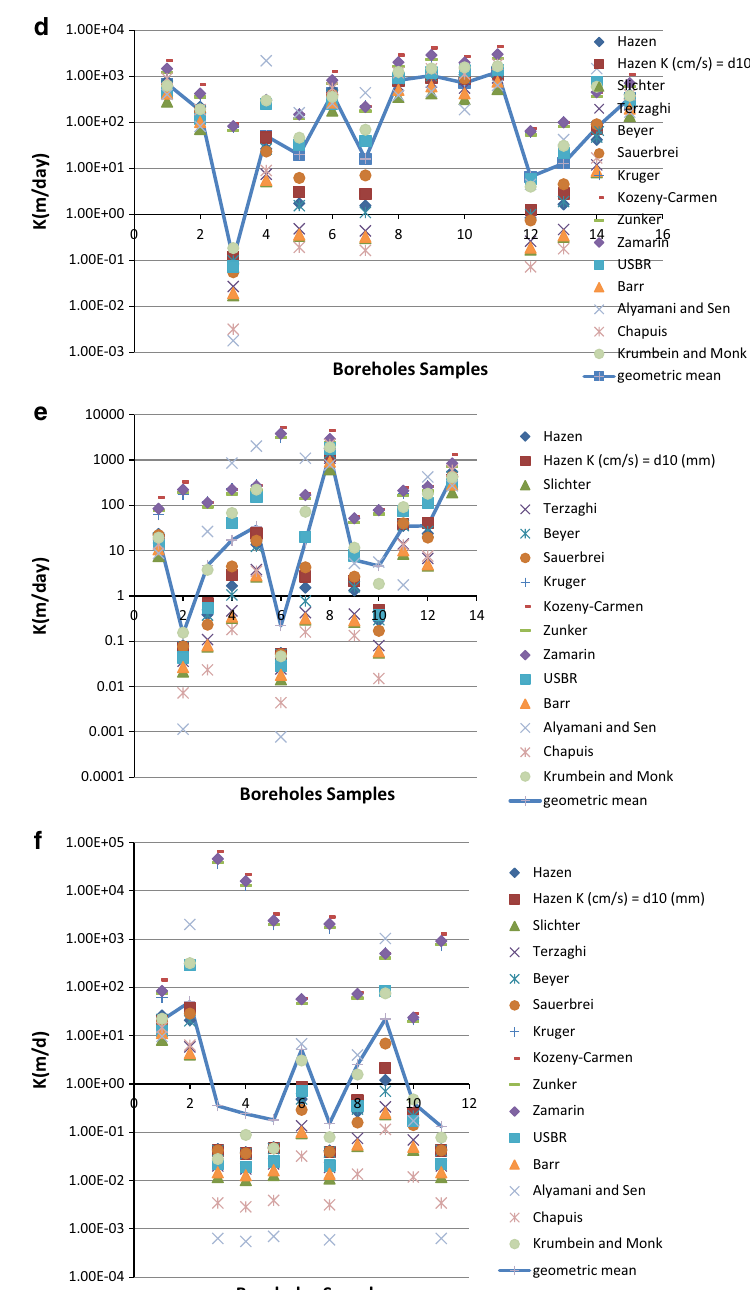
capacity. According to the results of the soil’s permeability, it is reasonable to classify this soil as gravel and medium sand. Based on the observations made, it could be con- cluded that the aquifer in the study area has indeed shown a potential for riverbank filtration (RBF), and there are bright chances to increase the water quality and water quantity of the studied area. A comparative analysis of K values was performed to g gain intelligence on the spatial variation of streambed K gs